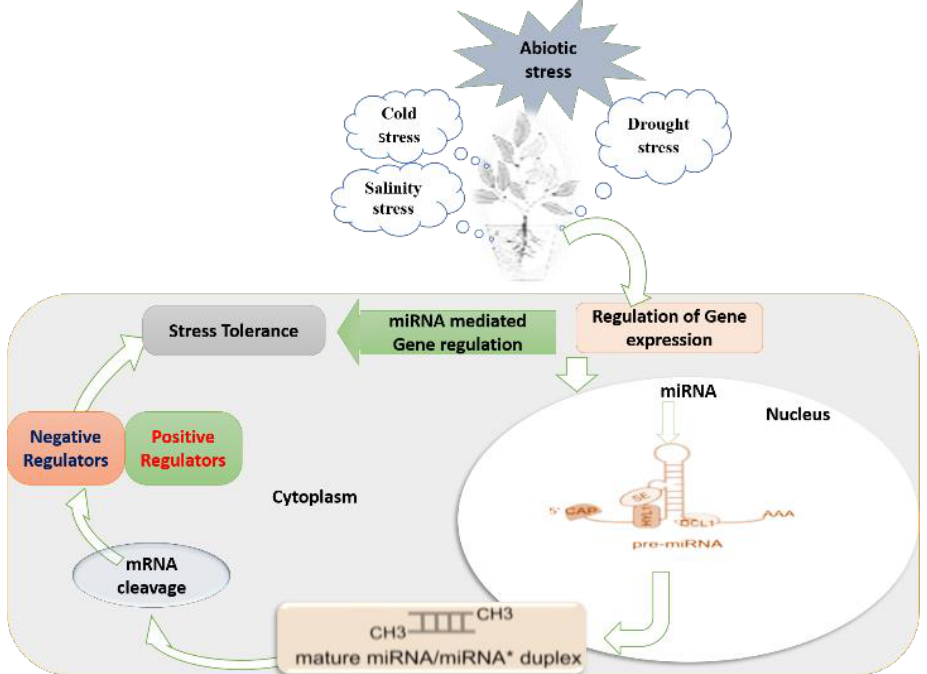
Figure 1. Schematic summary of miRNA-mediated regulatory mechanisms under abiotic stress in plant cells, with the particular formation process of miRNAs and miRNA mediated gene regulation: (1) miRNA gene is transcribed to a long sequence of primary miRNA (pri-miRNA). Primary miRNAs (pri-miRNAs) are transcribed from nuclear-encoded MIR genes by RNA polymerase II (Pol II), leading to precursor transcripts with a characteristic hairpin structure. (2) The pri-miRNA is cleaved to a stem-loop intermediate called miRNA precursor or